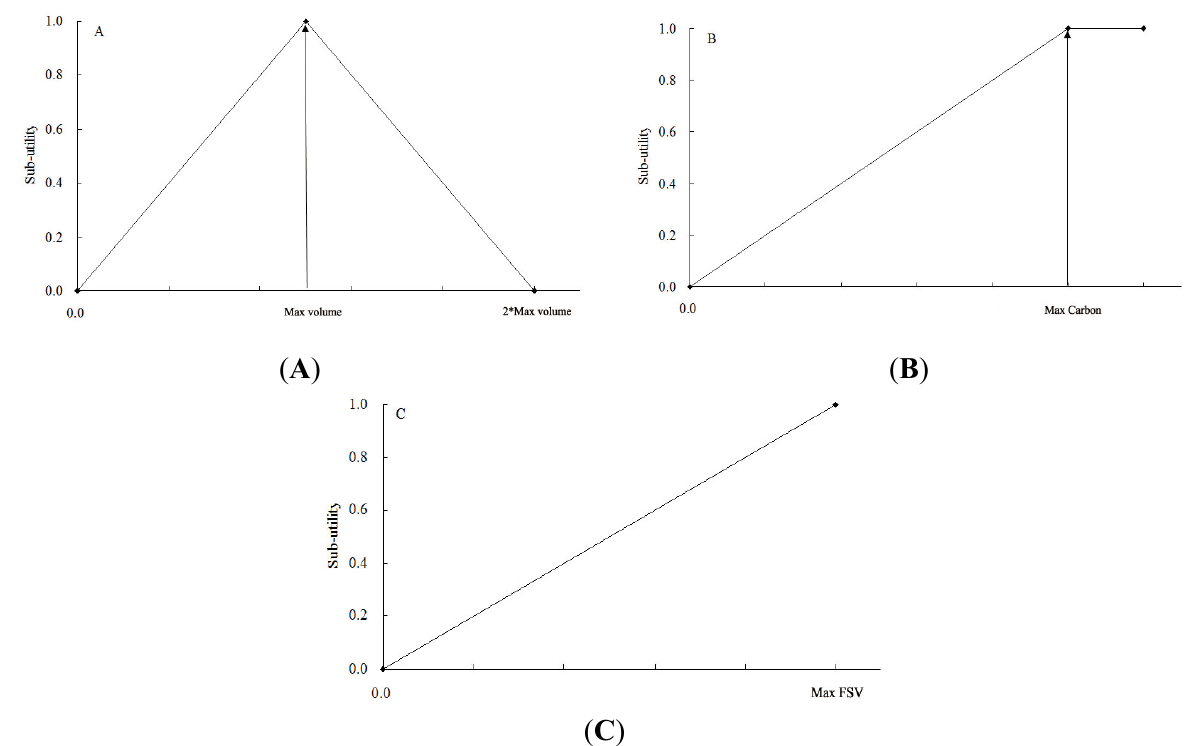
Figure 2. Shape of sub-utility functions for the planning formulation: ( A ) the timber production sub-utility increases linearly from 0.0 to 1.0 until a user-defined scheduled volume is achieved, after which it decreases linearly back to 0.0; ( B ) the carbon stock sub-utility function increases linearly from 0.0 to 1.0 until the user-defined carbon stock goal is achieved, after which it is 1.0; ( C ) the forest spatial value sub-utility function increases linearly from 0.0 to 1.0, which is achieved at the point of maximum forest spatial value for the